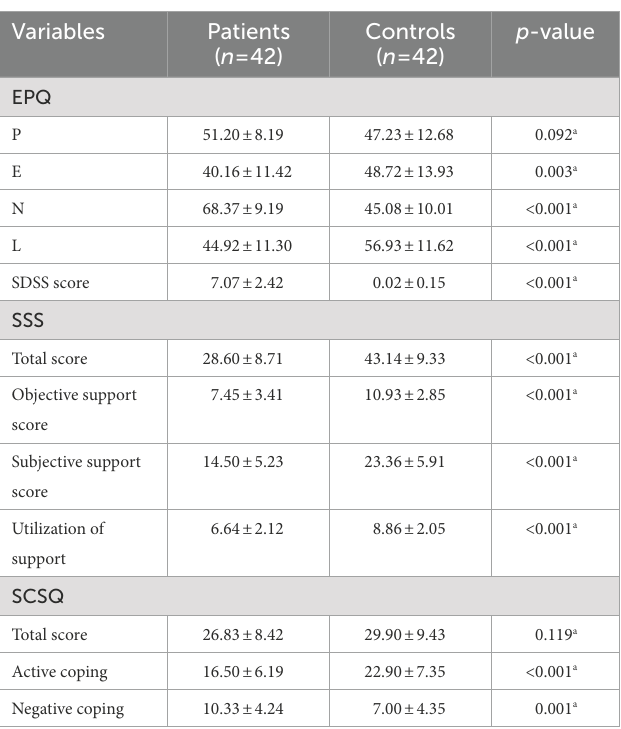
TABLE 2 Comparison of patients and healthy controls in psychological